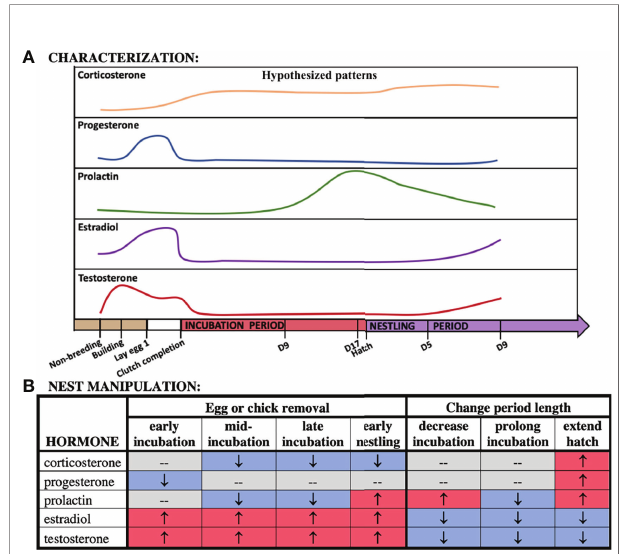
FIGURE 2 | Hypothesized patterns of hormones across our time points (A) and following nest manipulation (B)